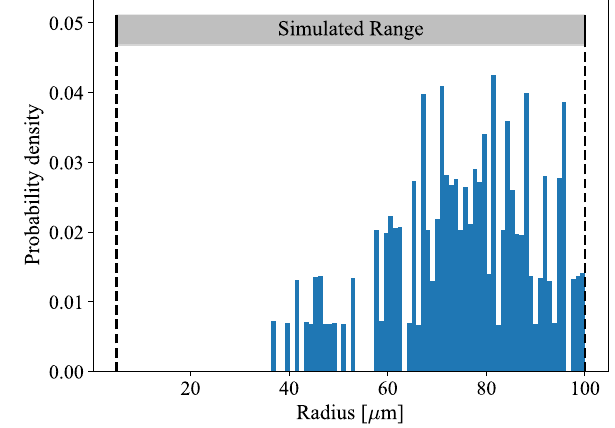
FIG. 18. Histogram showing the most likely dust particle radii as determined from the MC simulations. The average is 81 . 5 μ m, for this particular UFO